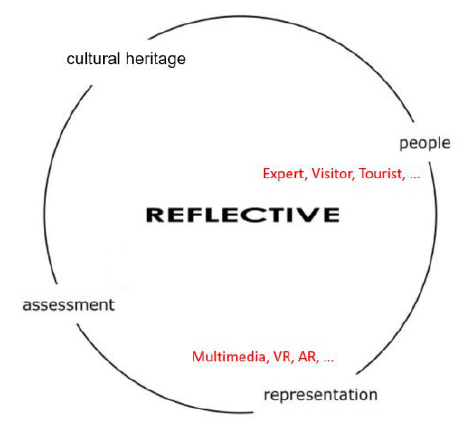
Fig. 11. The closed loop aims at stimulating a better interaction between people (expert operators, tourists, etc.) and built heritage through